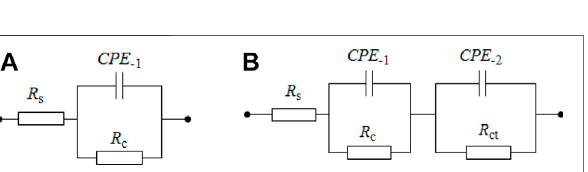
Frontiers in Materials |